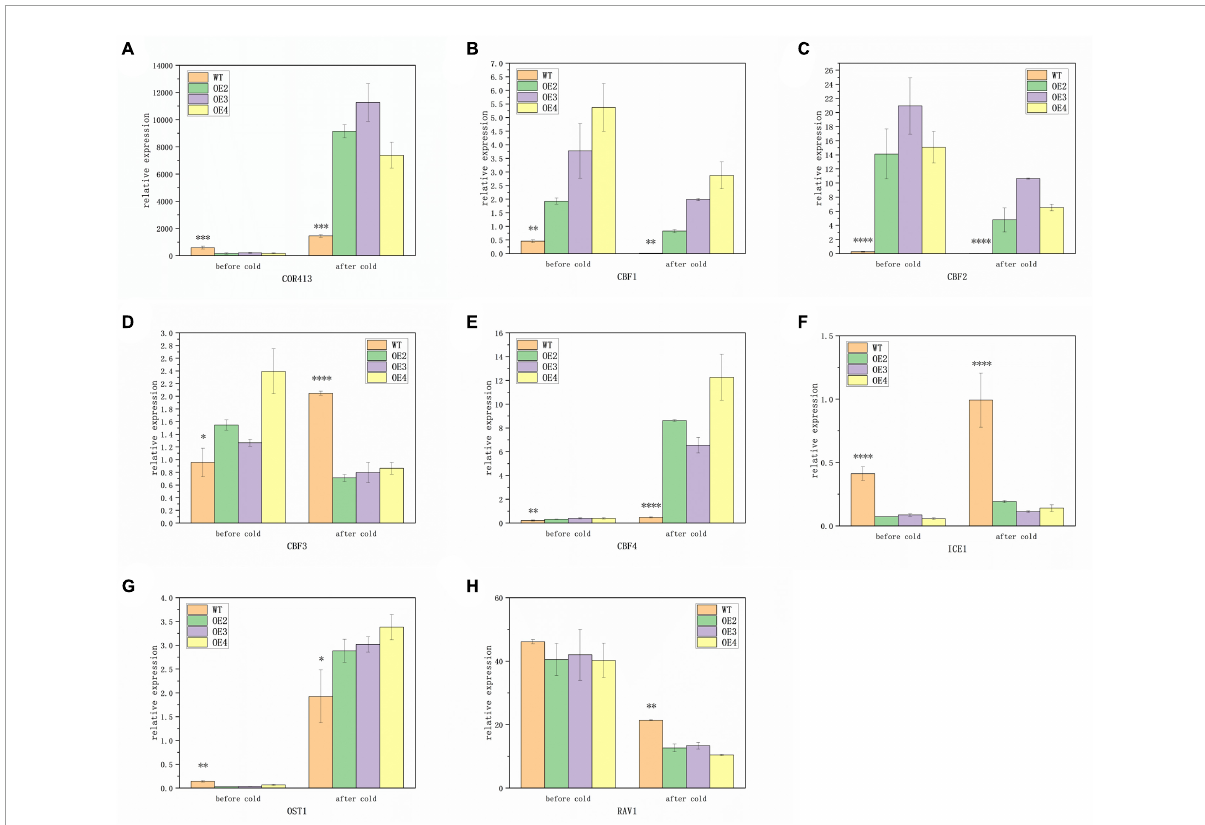
FIGURE5 Expression patterns of genes responsive to low temperatures. (A–H) Represent the expression levels of COR413 , CBF1-4 , ICE1 , OST1 , and RAV1 , in turn, under low temperatures. The values are means ± SD ( n = 3). ∗ , in graphs, indicates significant differences in the means at p < 0.05 between each level in transgenic lines and WT plants, and ∗∗ , ∗∗∗ , and ∗∗∗∗ , in graphs, indicate significant differences in the means at p < 0.01, p < 0.001, and p < 0.0001,